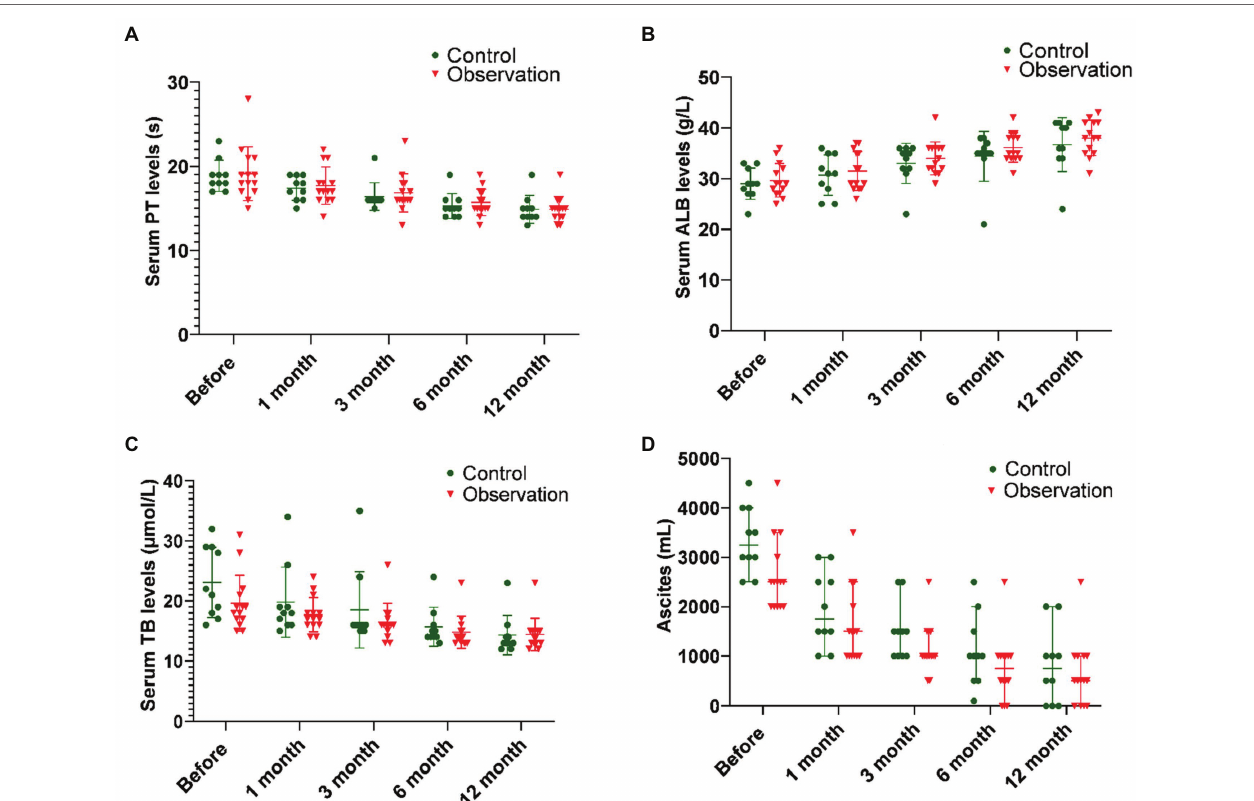
FIGURE 1 | Comparison of liver synthesis function and secretion function in DLC patients with T2DM before and after ABMI. (A) The PT before and after ABMI. (B) The serum ALB levels before and after ABMI. (C) The serum TB levels before and after ABMI. (D) The amount of ascites in the two groups before and after ABMI. DLC, decompensated liver cirrhosis; T2DM, type 2 diabetes mellitus; ABMI, autologous bone marrow infusion; PT, prothrombin time; ALB, albumin; and TB, total